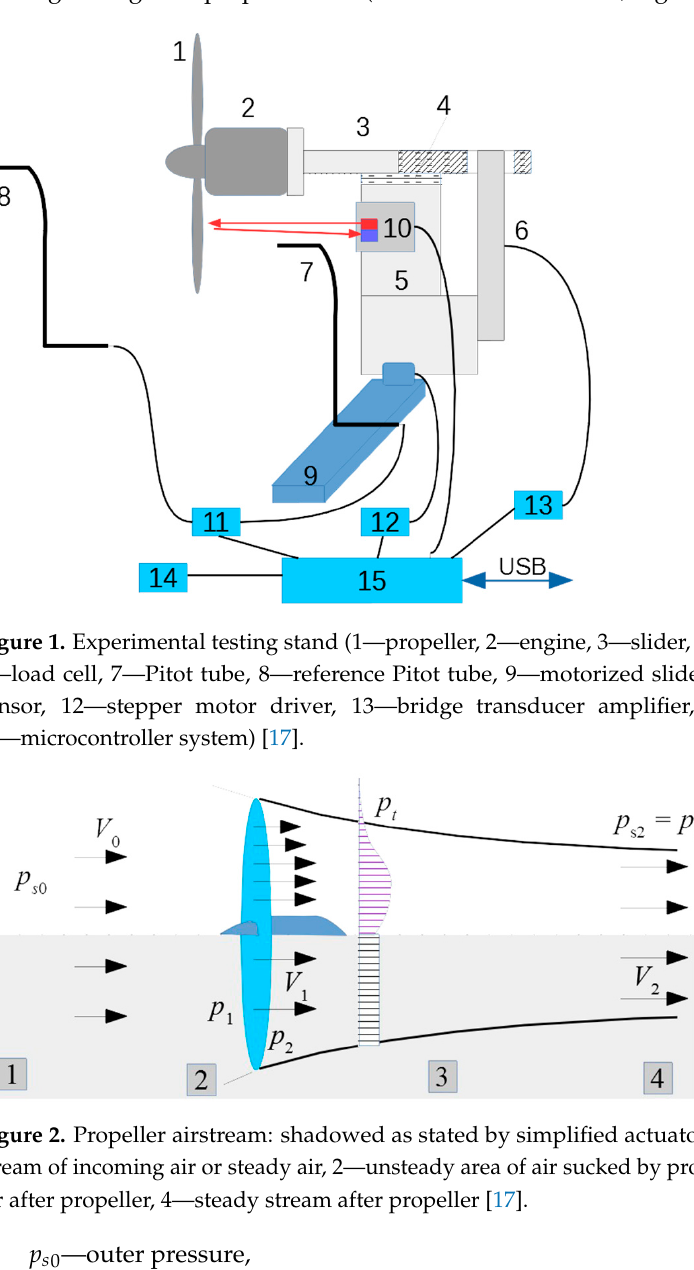
Figure 2. Propeller airstream: shadowed as stated by simplified actuator disk theory (1—uniform stream of incoming air or steady air, 2—unsteady area of air sucked by propeller, 3—unsteady area of air after propeller, 4—steady stream after propeller [17].